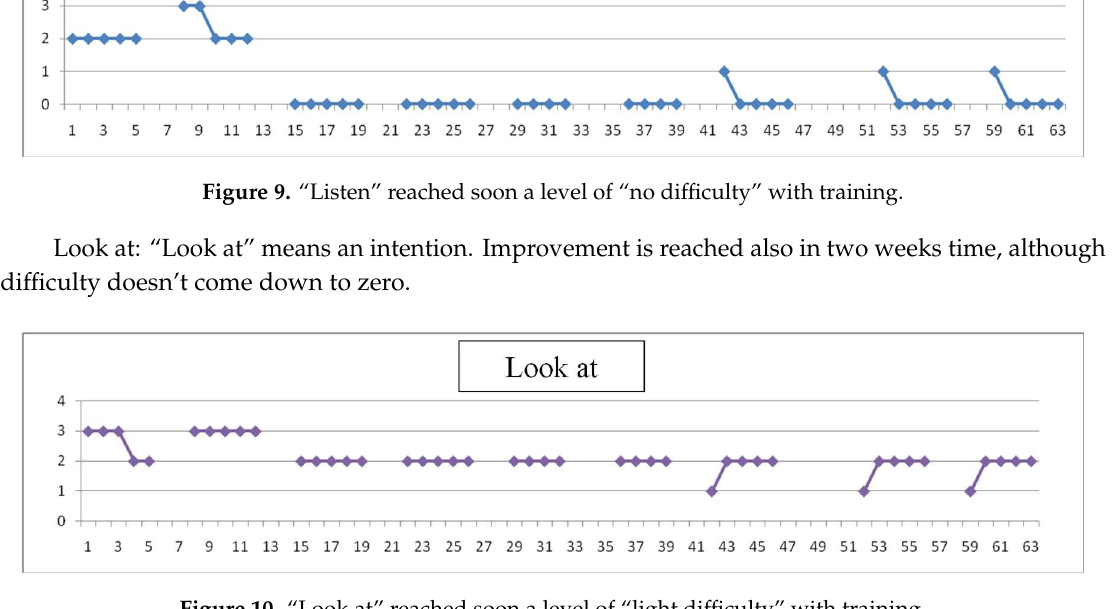
Figure 10. “Look at” reached soon a level of “light difficulty” with training.